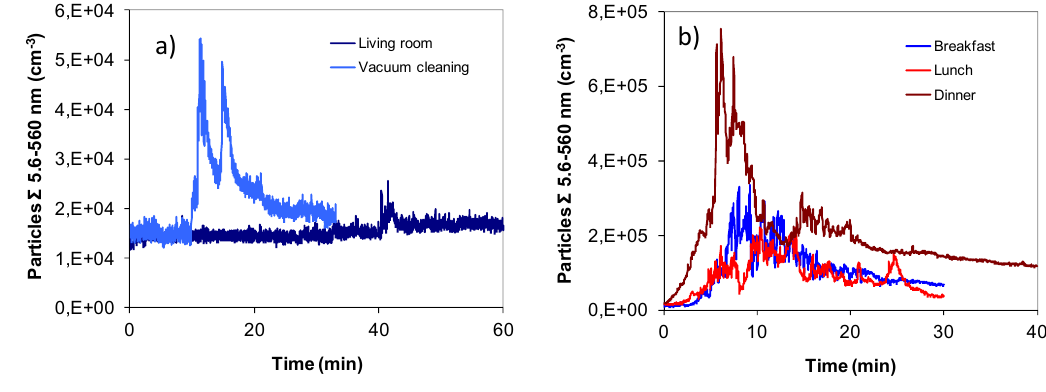
Figure 1. Temporal trends of total (5.6–560 nm) particle concentration ( a ) in a living room with no aerosol generation and during vacuum cleaning and ( b ) in a kitchen during breakfast, lunch and dinner preparation and